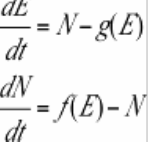
Fig. 7 . Population dynamic model of agricultural regime